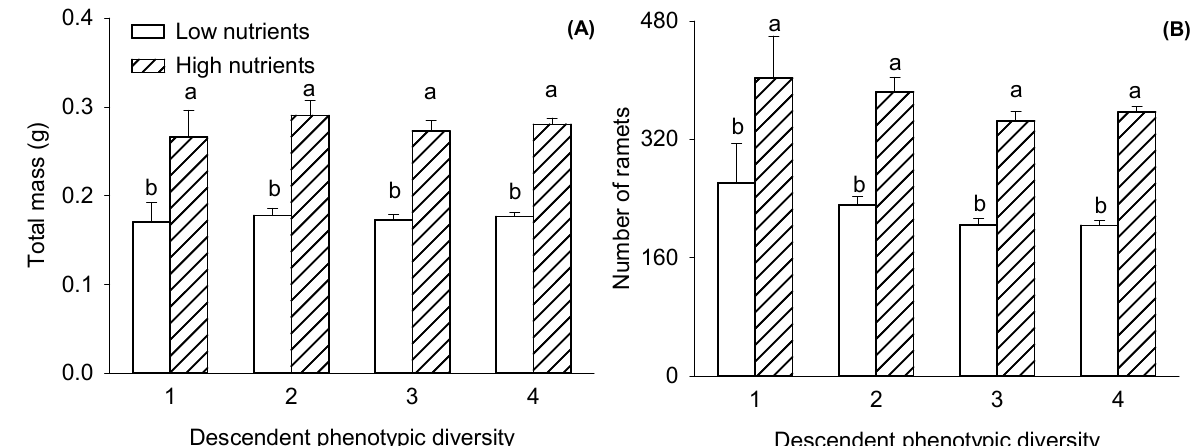
Figure 2. Total mass ( A ) and number of ramets ( B ) of Spirodela polyrhiza in response to different descendent phenotypic diversity caused by ancestor environmental variation and nutrient availability for the second phase of Experiment 1. The values are means and standard errors. Different letters indicate significant differences among treatments. See Table 1 for ANOVA results.